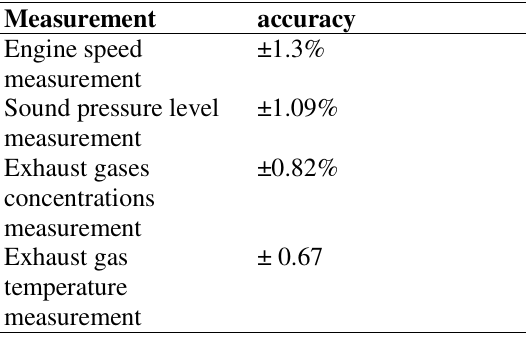
Measurement type and accuracy for present